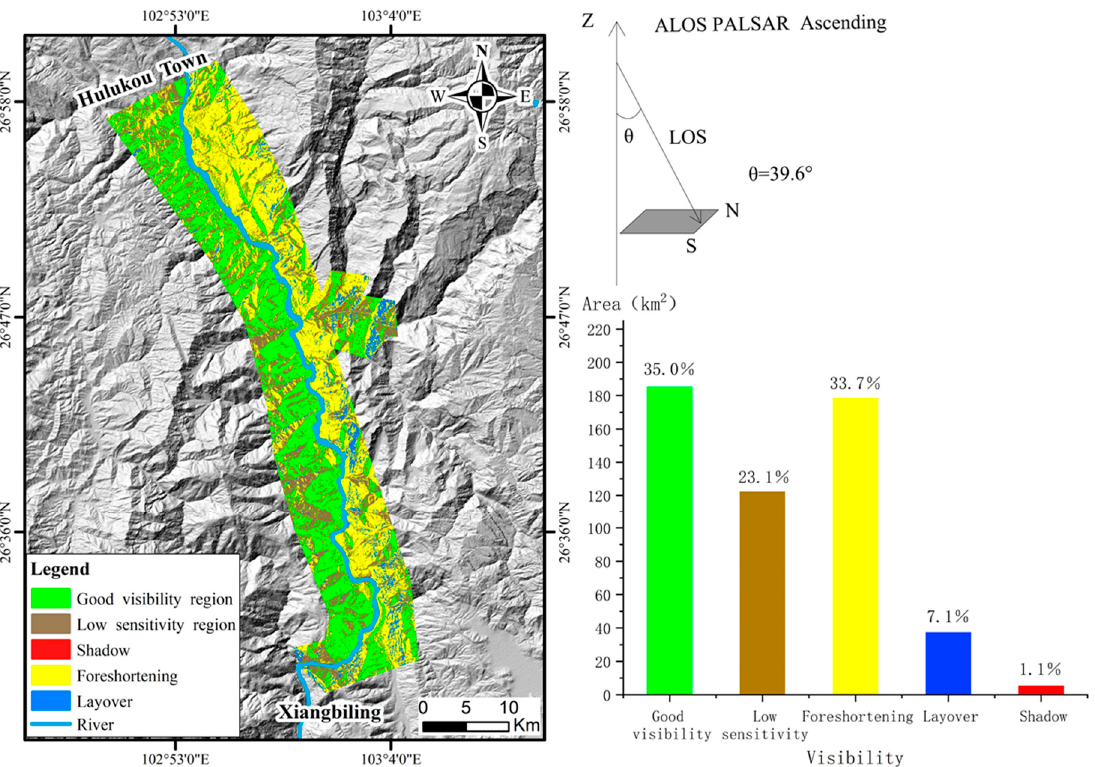
Figure 14. Visibility results of ALOS PALSAR ascending data in the study area.